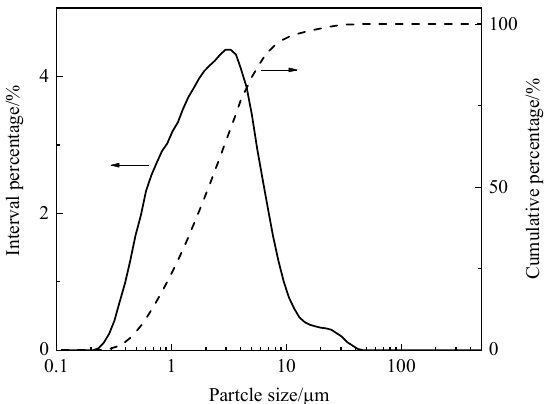
Figure 8. Particle size distribution curve for the slag-tailing admixtures of CS-20.